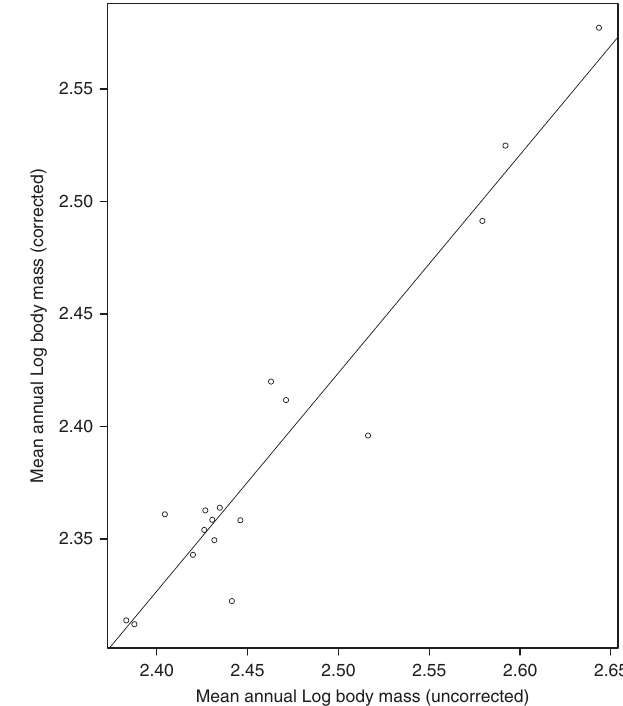
Fig. 1 The evolution of log body mass over time, corrected for seasonal variation linked to capture date. We regressed capture date (days away from the center of the breeding season (July 1st)) on log body mass (the dependent variable), having year a factor. Vertical error bars signify one standard error. The data reveal a negative trend in body mass consistent with an OU-model. The dotted line represents the estimated adaptive optimum ( θ ) for log body mass (2.35)